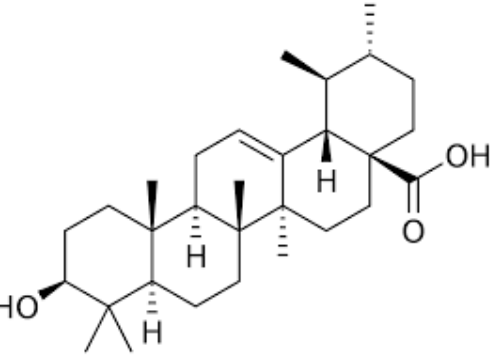
Figure 1. Chemical structure of ursolic acid (UA). Figure created in